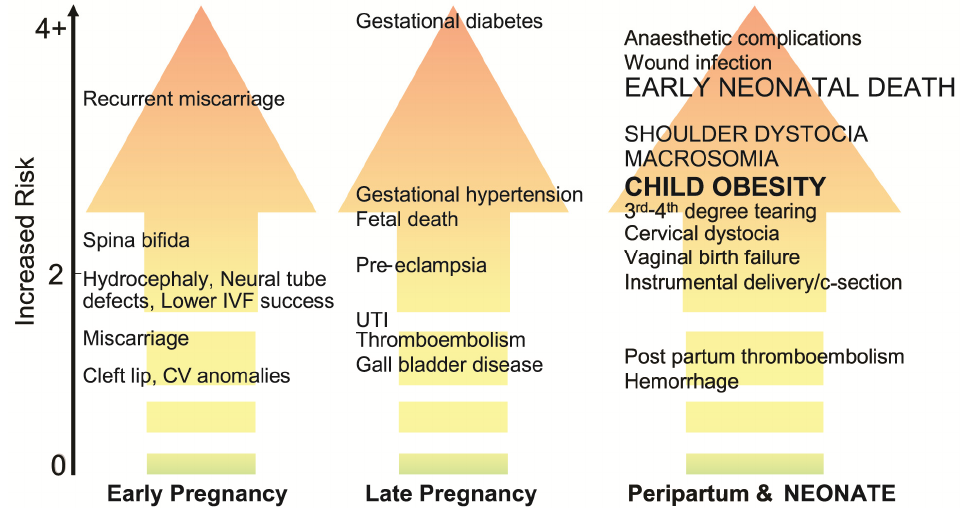
Figure 1. Risks associated with pregnancies complicated by overweight or obesity. The x-axis shows the time course and the y-axis illustrates the degree of elevated risk for each outcome based on published literature (IVF = in vitro fertilization, CV = cardiovascular, UTI = urinary tract